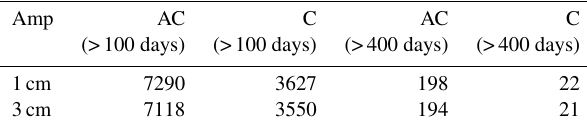
Table 1. The census of long-lived eddies, where “Amp” represents the amplitude threshold used in eddy detection, and “C” and “AC”, respectively, represent cyclonic and anticyclonic